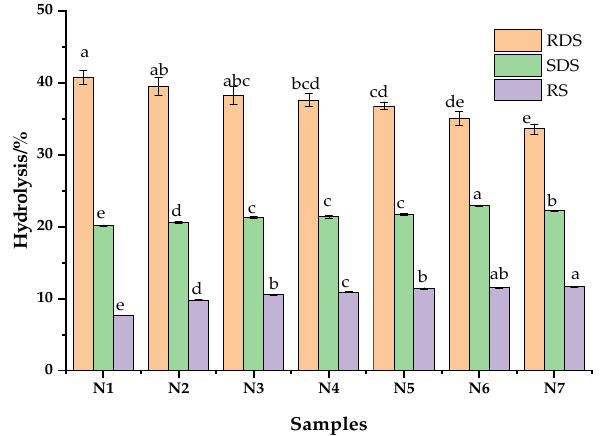
Figure 4. The RDS, SDS, and RS levels in tartary buckwheat noodles with different HTBF levels. Bars bearing the same letter within the same starch cultivar are not significantly different ( p < 0.05). N1–N7 respectively represent noodles with 0%, 10%, 20%, 30%, 40%, 50%, and 60% HTBF.